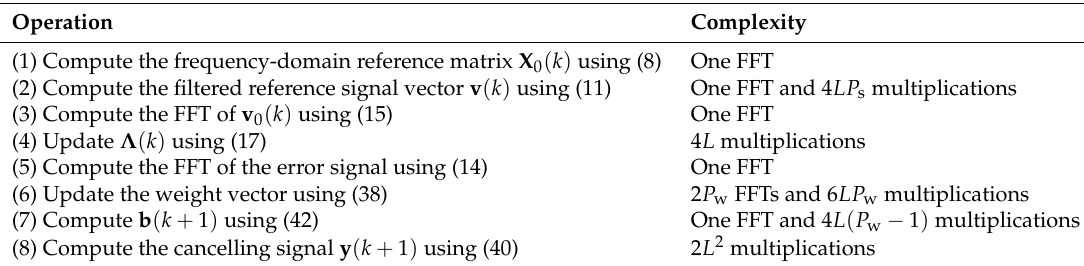
Table 7. Fink’s delayless algorithm